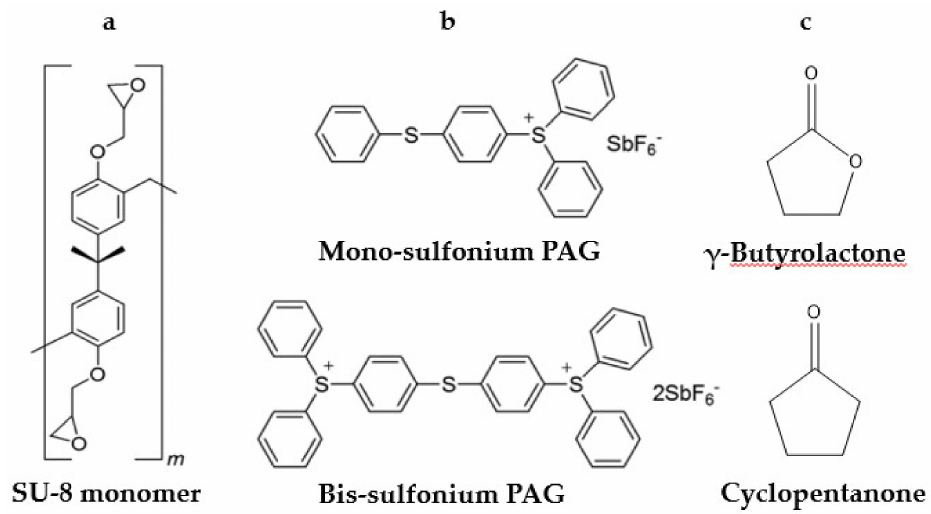
Figure 2. The components of SU-8: ( a ) SU-8 monomer; ( b ) sulfonium PAGs; ( c ) solvent. Adapted from Ref. [35] with the permission of AIP